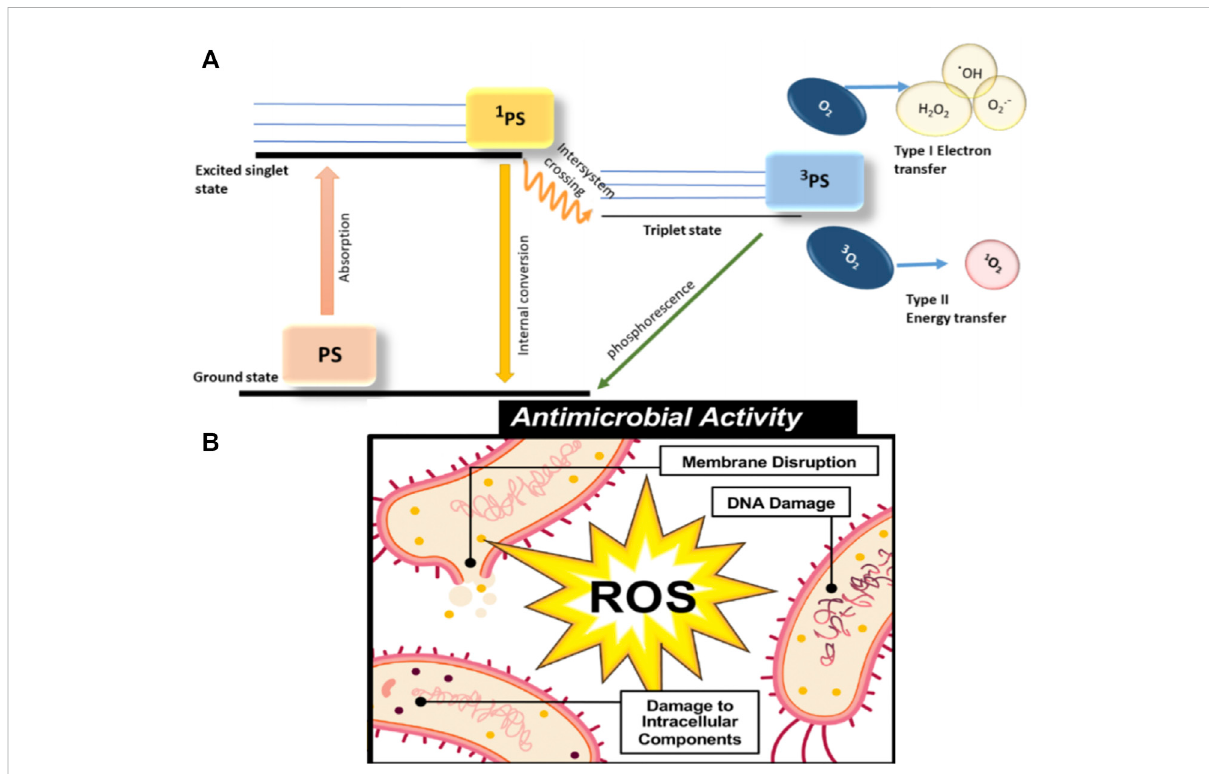
FIGURE 1 (A) Illustration of the photochemical mechanisms of PDT types I and II. 1 PS, PS in a fi rst excited state; 3 PS, triplet-state PS; · OH, hydroxyl radical; O 2 − , superoxide anion; and H 2 O 2 , hydrogen peroxide. PS reaches the 1 PS by absorbing energy, and a part of 1 PS is converted to 3 PS by intersystem crossing, and the other part is converted back to the ground state by internal conversion. Triplet PS produces ROS in two ways: Type Ⅰ electron transfer; Type II energy transfer. After that, 3 PS goes back to the ground state (PS) through phosphorescence (Ghorbani et al., 2018). (B) Illustration of the three ROS antimicrobial mechanisms: Membrane disruption; DNA damage; and damage to intracellular components (Knoblauch and Geddes,